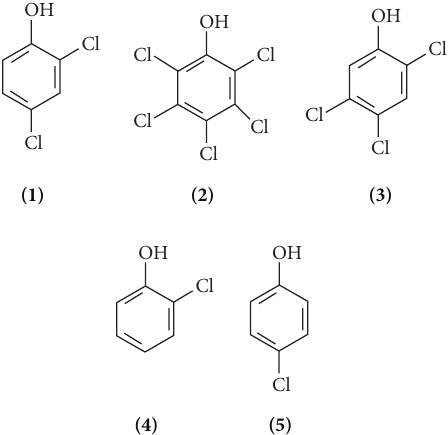
Figure 1: Commercially the most important chlorophenols. 2,4- dicholorophenol(2,4-DCP) ( 1 ) ;pentachlorophenol(PCP) ( 2 ) ;2,4,5- trichlorophenol (2,4,5-TCP) ( 3 ) ; 2-chlorophenol (2-CP) ( 4 ) and 4- chlorophenol (4-CP) ( 5 )